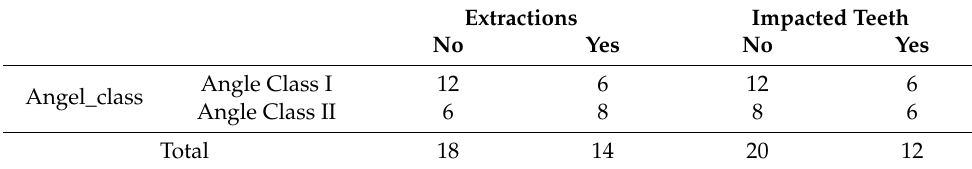
Table 1. Distribution of patients according to Angle class, extractions, and impacted teeth.